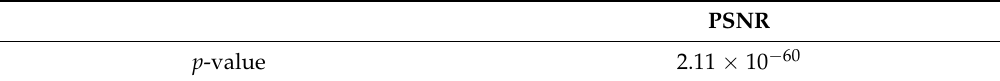
Table A2. p -value obtained for ANOVA test for Otsu [11], two-peak [27], Kapur et al. [12], DTP-NET (fine-tuned model) [46], and the proposed